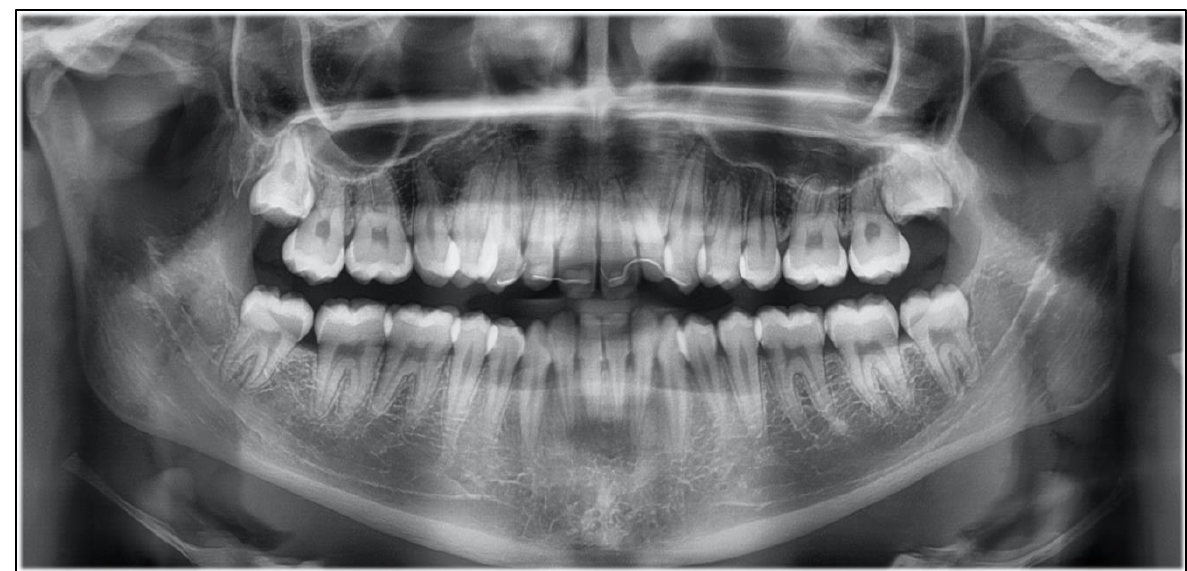
Figure 1. A 21-year-old female with skeletal Class III, dental class III on the right side and Class I on the right side and severe crowding in the lower arch before treatment.